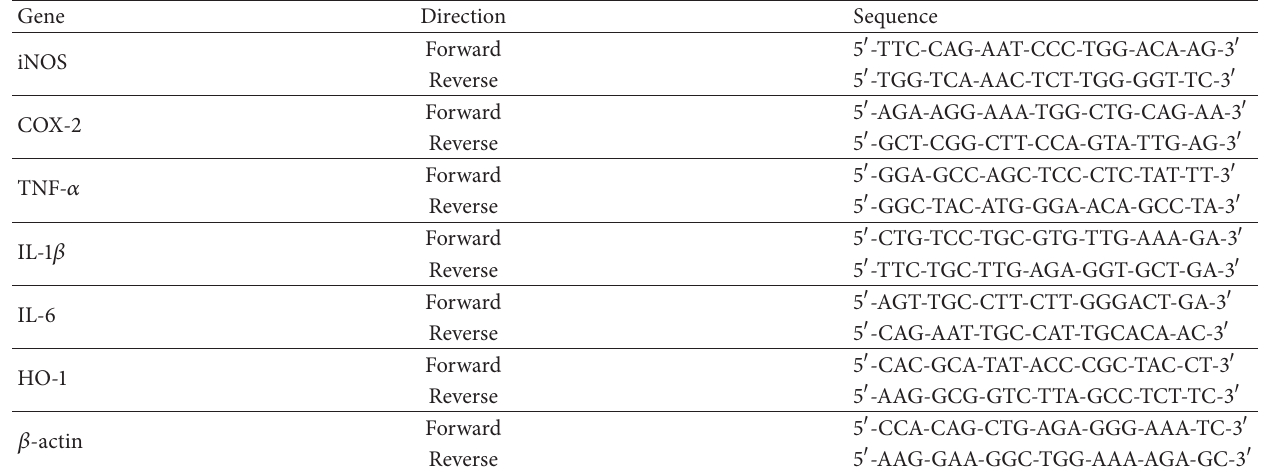
Table 1: Sequences of primers used for